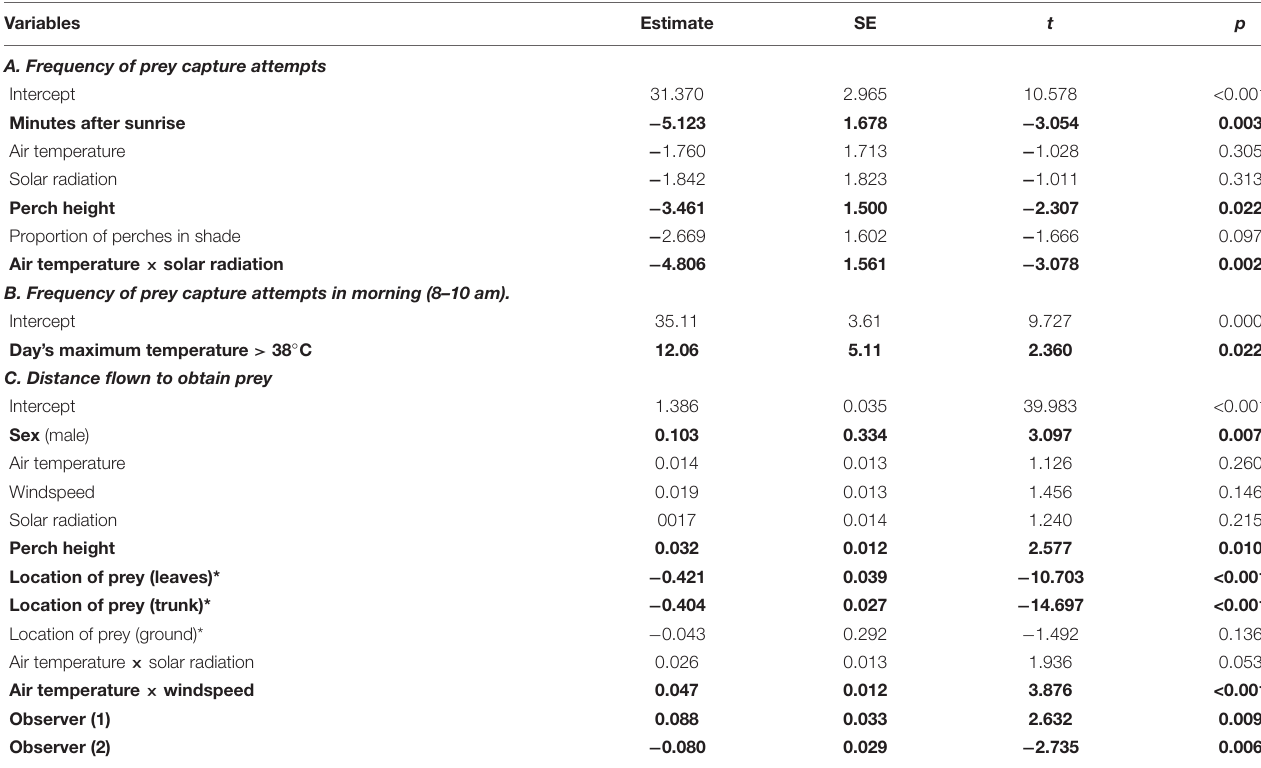
TABLE 1 | Results of REML mixed effects models testing for factors associated with foraging